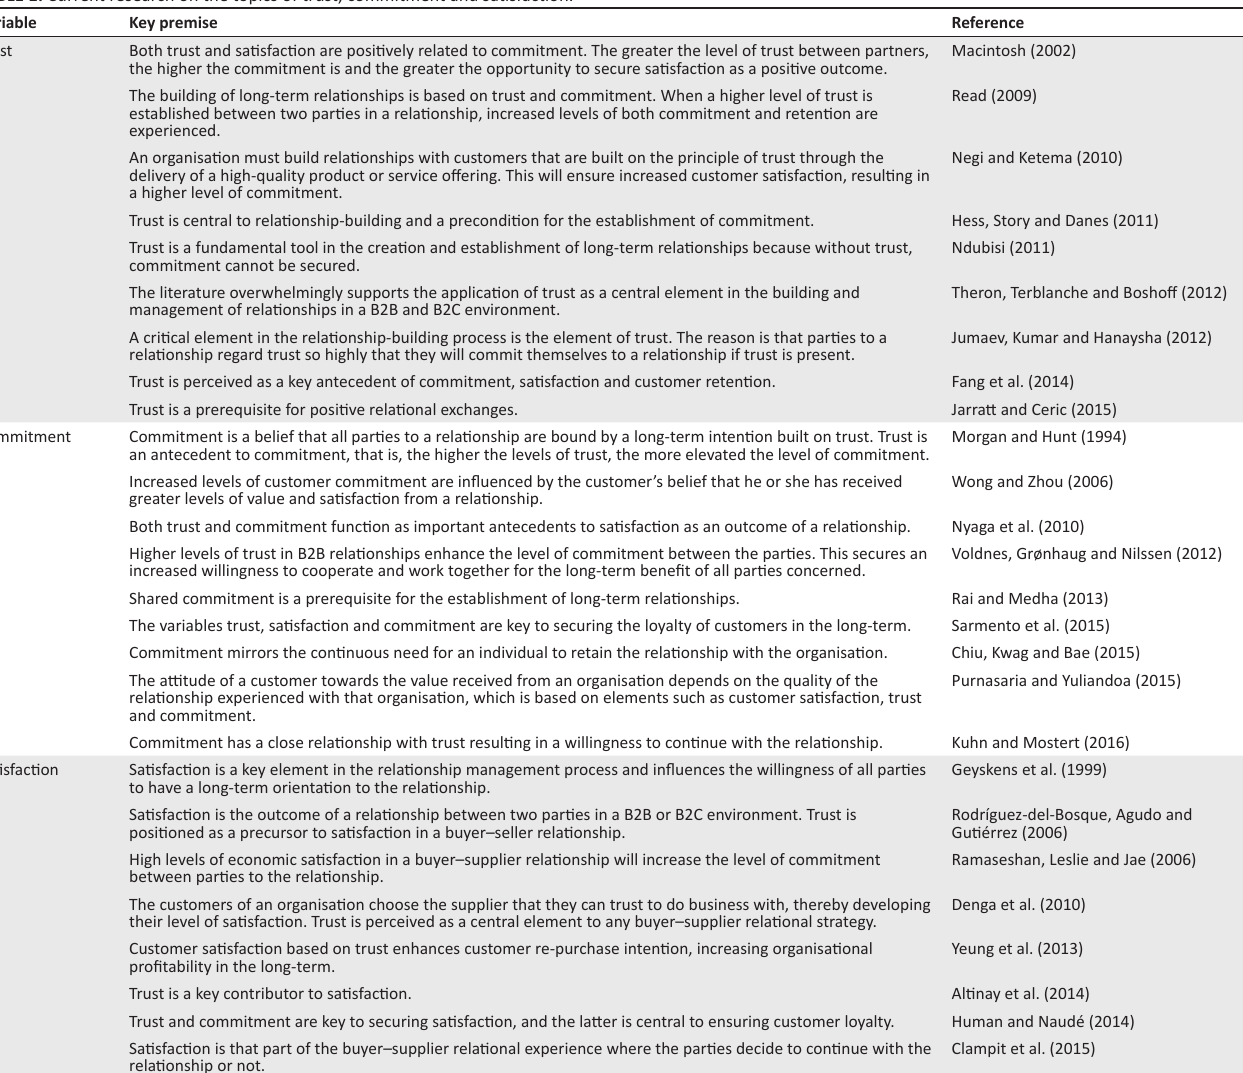
TABLE 1: Current research on the topics of trust, commitment and